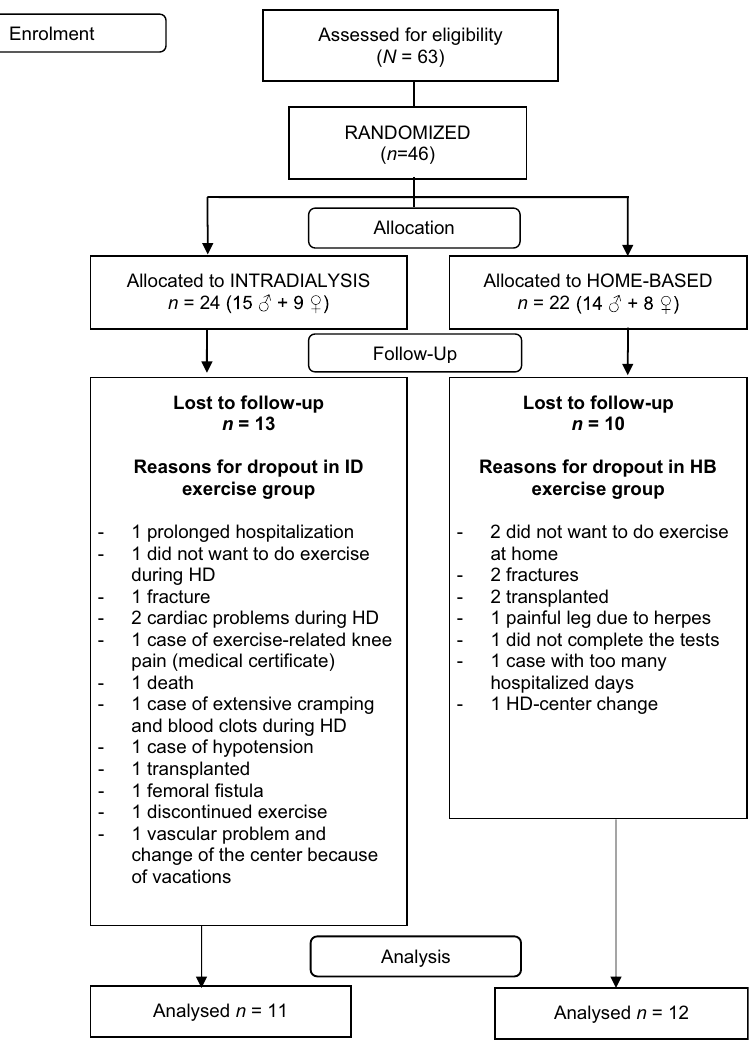
Figure 1. Flow chart depicting the progression of the participants completing the intradialytic versus home- based exercise programs through the trial. Patient adherence and dropouts are